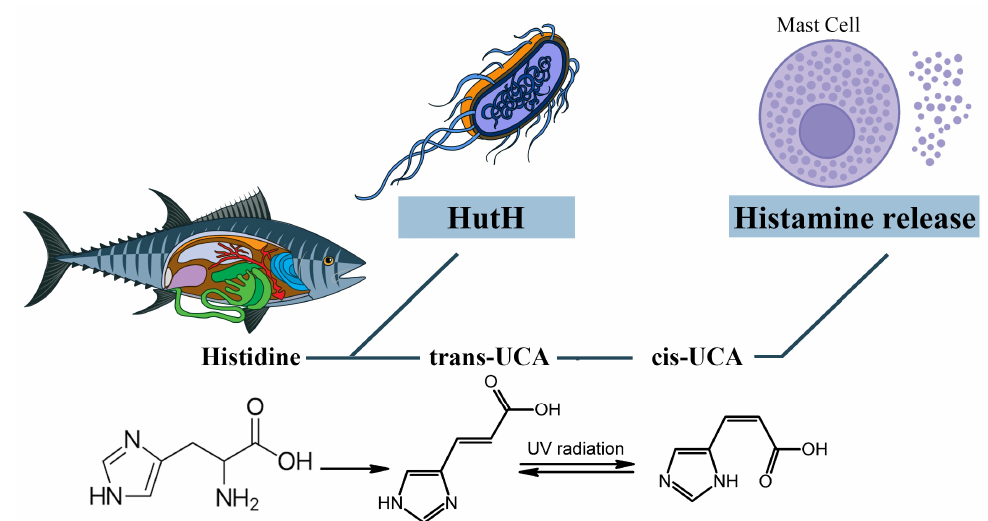
Figure 6. The role of cis-urocanic acid in the SFP mechanism. Histidine is converted into trans- urocanic acid, which accumulates in fish. Over time, the isomerization of trans-urocanic acid to cis-urocanic acid occurs, which plays the role of histamine liberator. HutH—histidine ammonia-lyase, UCA—urocanic